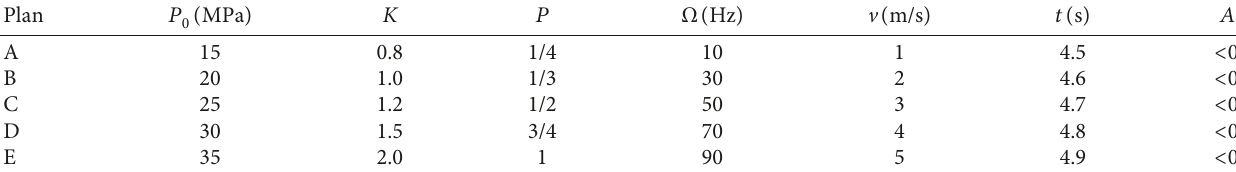
Table 1: The safety factor of the coupling model between the surrounding rock and U-shaped